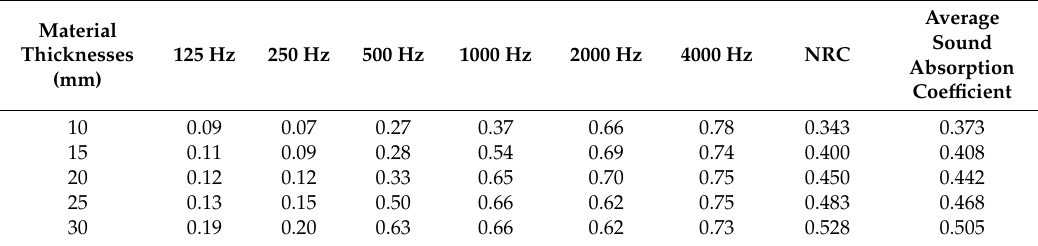
Table 3. NRC and average sound absorption coe ffi cient of composite materials prepared with di ff erent material thicknesses.